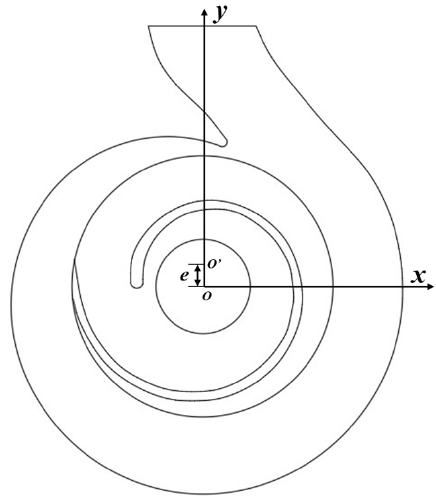
Figure 7. Diagram of the Eccentricity of the Impeller.